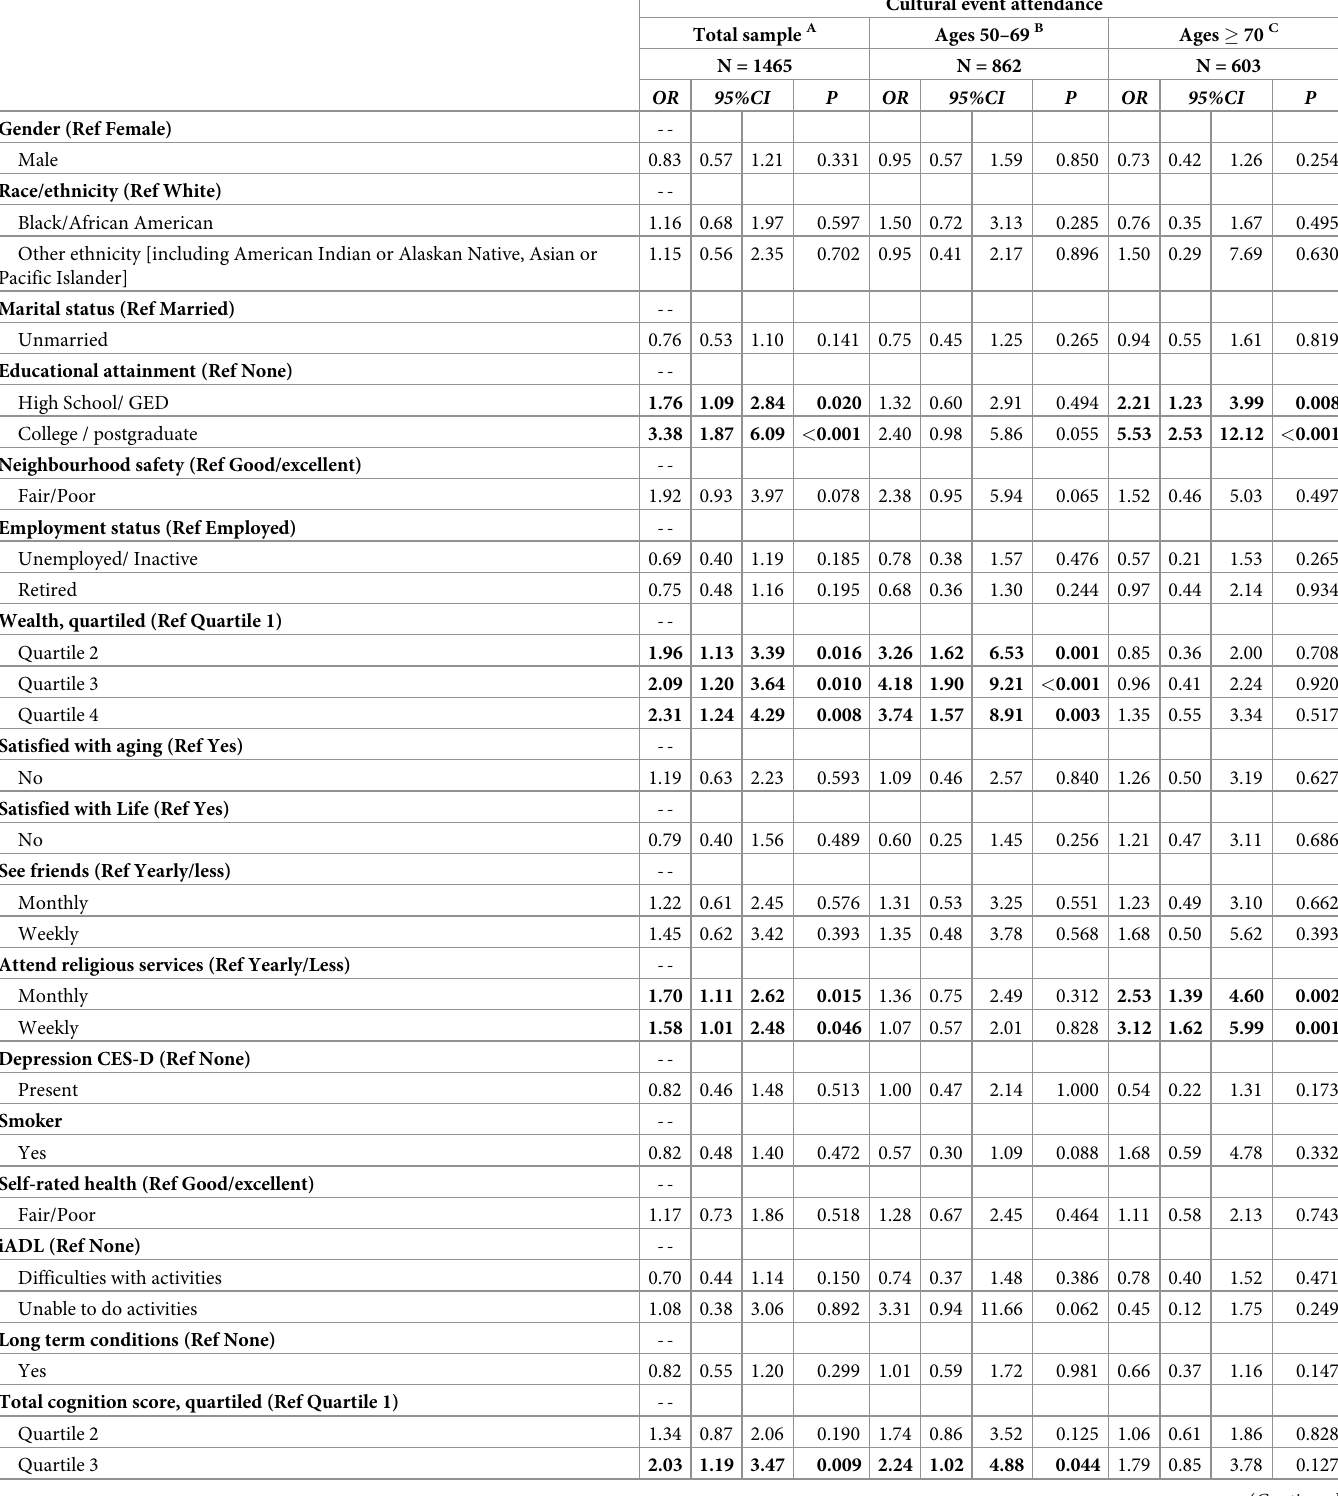
Table 2. Age related differences in predictors of cultural event attendance in the past 12 months from logistic regression